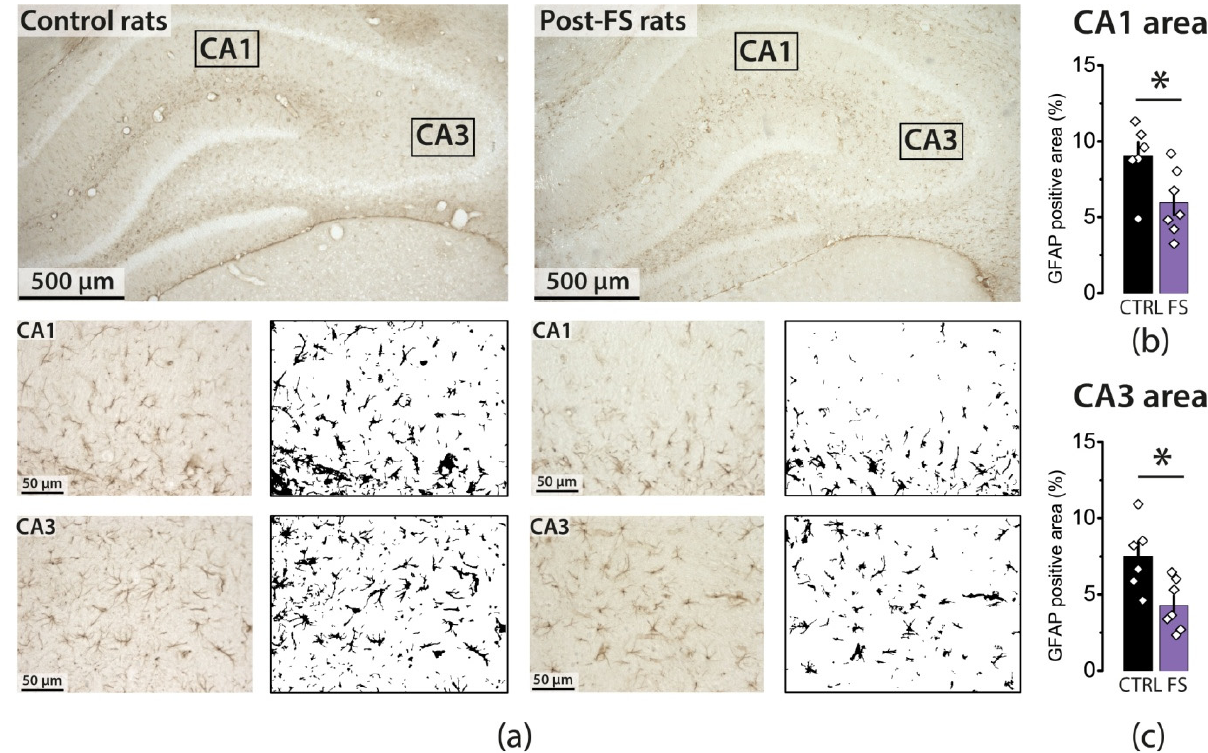
Figure 4. In animals at P21 after FSs, the area occupied by GFAP ‐ positive objects was significantly less than in the control group. Animals at P12 after FSs showed no change in the area occupied by GFAP ‐ positive objects. ( a ) Representative images of hippocampal sections (×5 magnification) and images of the stratum radiatum of the CA1 and CA3 fields (×40 magnification) and their black ‐ and ‐ white masks, which were obtained in the ImageJ program and used to count the area occupied by GFAP ‐ positive objects. The averaged area occupied by GFAP ‐ positive objects in the stratum radia ‐ tum of the CA1 ( b ) and CA3 ( c ) fields. The diamonds show the individual values for each rat. As ‐ terisks indicate significant differences between groups according Student’s t ‐ test: * p < 0.05.